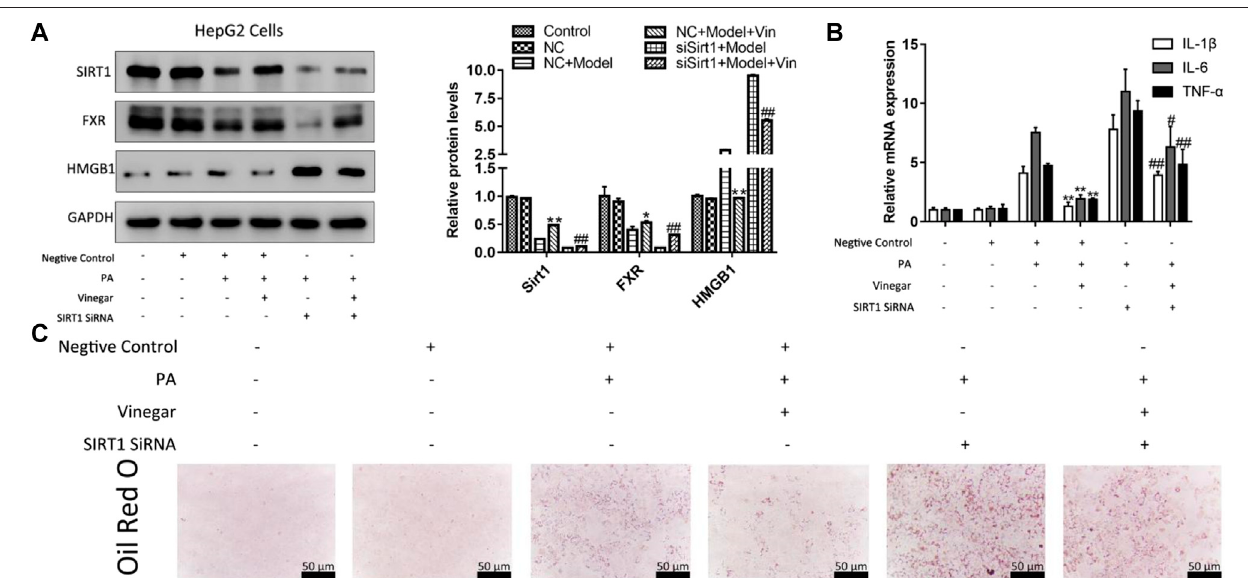
FIGURE 7 | Effffect of aromatic vinegar on silent information regulator of transcription 1 (SIRT1)/FXR and SIRT1/high mobility group box 1 (HMGB1) pathway in HepG2 cells transfected withSIRT1 siRNA. (A) The protein levels ofSIRT1, FXRand HMGB1; (B) ThemRNA levels ofinterleukin-1 β (IL-1 β ), interleukin-6 (IL-6) and TNF- α ; (C) Oil Red O staining ( × 400 magni fi cation; Scale bar (cid:2) 50 µm). Values are expressed as the mean ± SD (n (cid:2) 3). * p < 0.05, ** p < 0.01 compared with model group transfected with negtive control siRNA (NC + Model); # p < 0.05, # p < 0.01 compared with model group transfected with SIRT1 siRNA (siSirt1 +